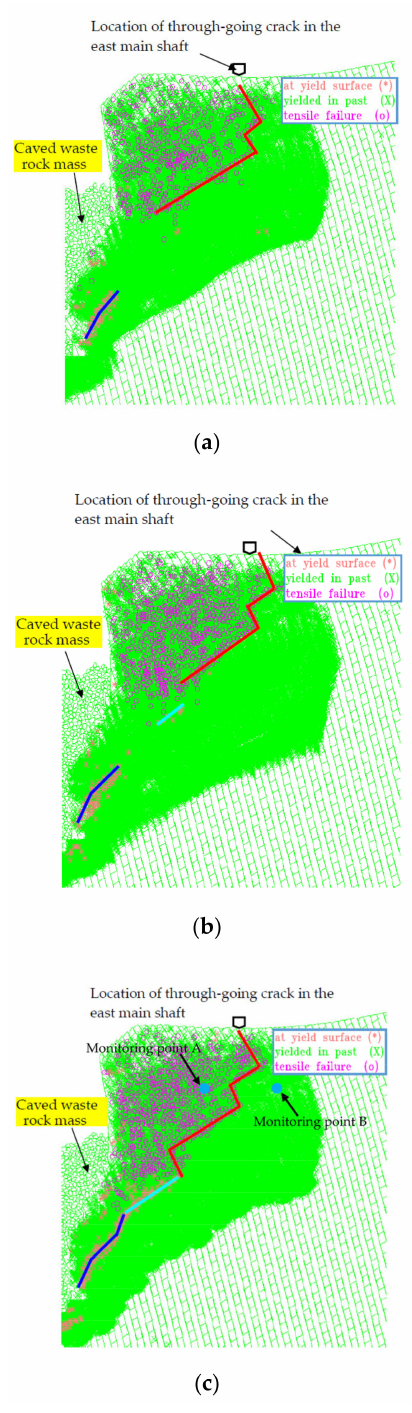
Figure 16. Plastic failure zones in the footwall corresponding to different excavation levels. The three stages shown correspond to depths of: ( a ) − 375.5 m, ( b ) − 393 m, and ( c ) − 410.5 m. Red lines denote the flexural-toppling failure surface; cyan lines denote the compression and slipping-toppling failure surface; and blue lines denote the shear-slipping failure